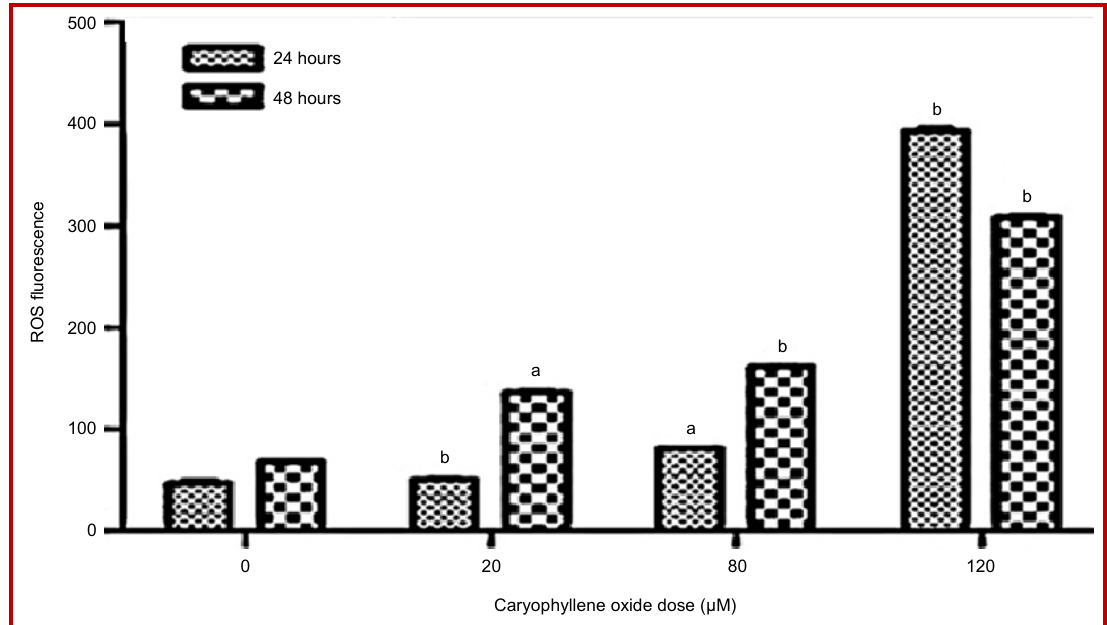
Figure 5: Reactive oxygen species (ROS) generation induced by different doses of caryophyllene oxide at two different time inter- vals in MG-63 human osteosarcoma cells. The cells were treated with 0, 20, 80 and 120 µM dose of caryophyllene oxide, stained with 20 µM 2, 7 ‑ dichlorodihydrofluorescein diacetate for 20 min and then analyzed by flow cytometry. Data are the mean ± SE of three experiments. a p<0.01 vs. control, b p<0.05 vs.